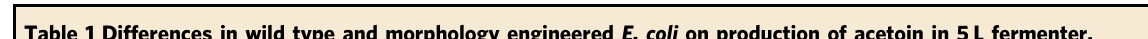
Fig. 5 Shortening cell division for acetoin production by the BANA system. a The schematic diagram of acetoin biosynthesis pathway in E. coli D1. b The schematic diagram of BANA containing the BLAT and NRAT. c Enhancing acetoin production by BANA regulation. BLAT was used to control nrdAB and ftsZA , and at the same time NRAT controlled rpoS . d Effect of illumination combination on the C + D periods and acetoin production. H, M, and L were 0.8, 0.3, and 0.2 W/cm 2 , respectively (Supplementary Fig. 27A – C). The genes in the C + D periods of cell division were constitutively expressed in E. coli D1, resulting in E. coli D2. The rpoS gene was constitutively expressed in E. coli D2, resulting in E. coli D3. The genes in the C + D periods of cell division were controlled by blue light in E. coli D1, resulting in E. coli DB5 (Blue-H-M-M represented 0.8 W/cm 2 blue-light in phase I and 0.3 W/cm 2 blue-light in phase II and phase III). The rpoS gene was controlled by NIR-light in E. coli DB5, resulting in E. coli DN4 (NIR-M-H represented 0.3 W/cm 2 NIR-light in phase II and